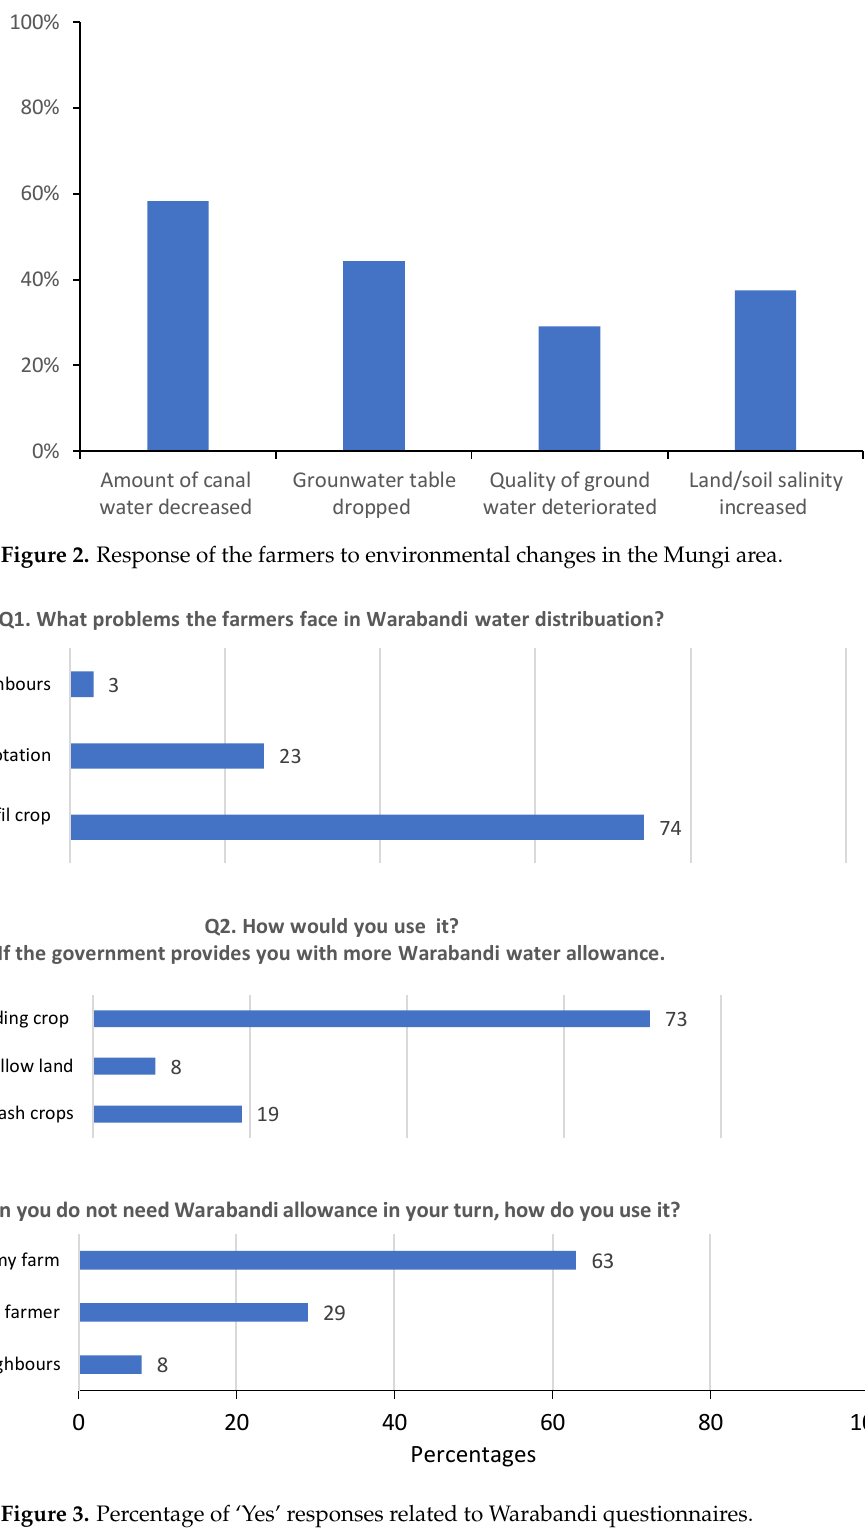
Figure 3. Percentage of ‘Yes’ responses related to Warabandi questionnaires.